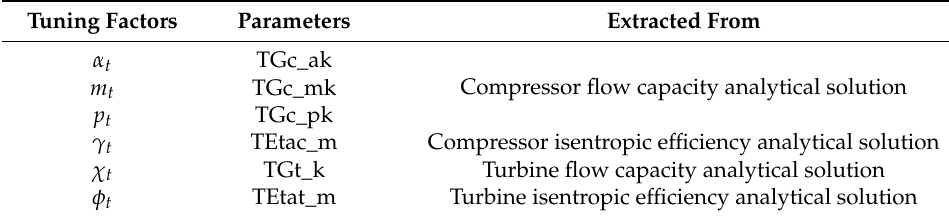
Table 3. All potential tuning